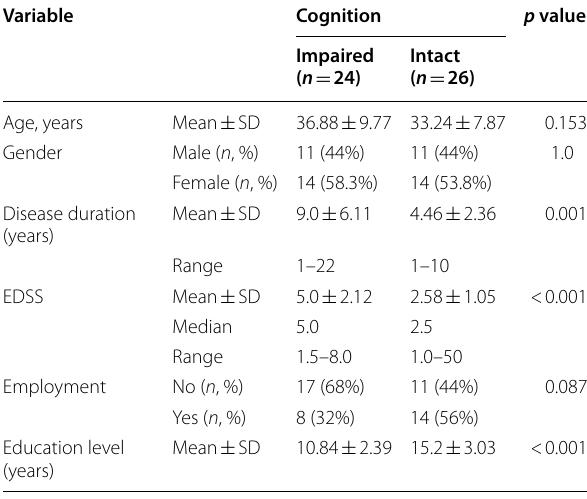
Table 3 Demographic and clinical data of patients with multiple sclerosis according to